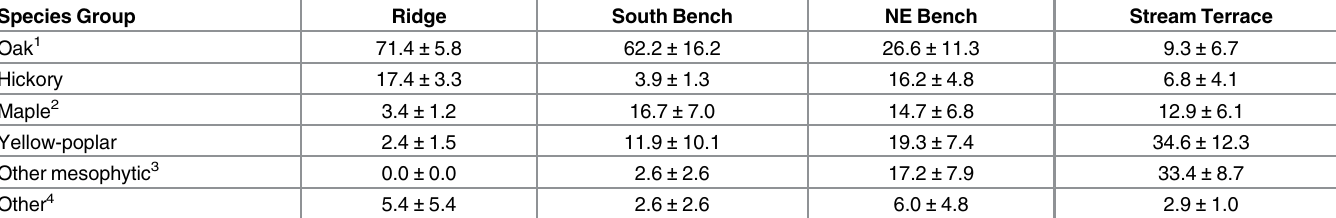
Table 2. Percentage of tree basal (mean ± standard error) area accounted for by different species groups for each topographic class where the common gardens were